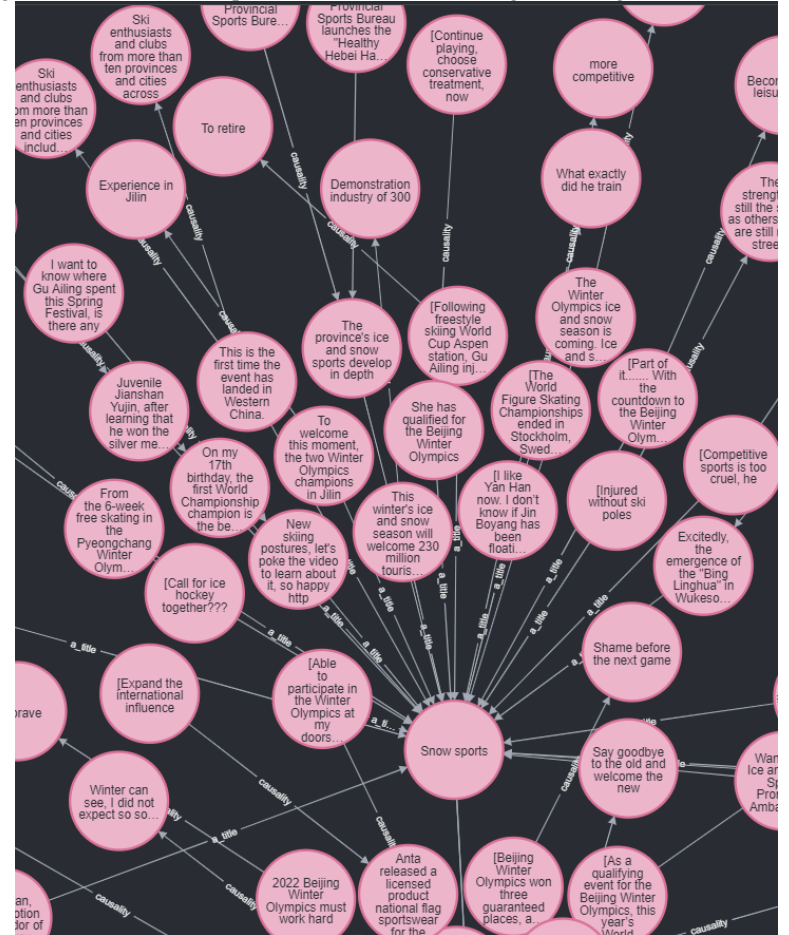
Fig. 7. Partial graph of microblog netizens from January to